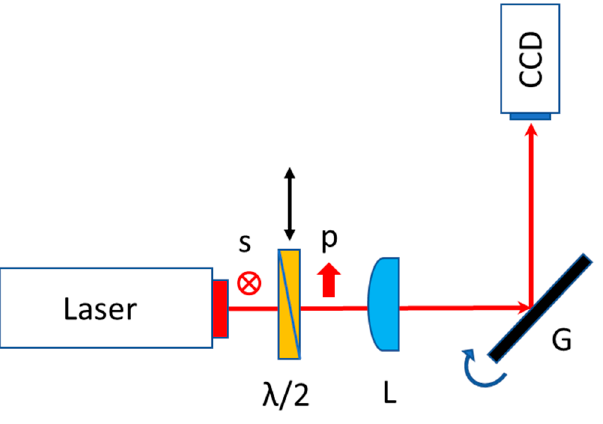
Figure 11. Experimental setup. λ /2 — half-wave plate, L — lens, G — grating.